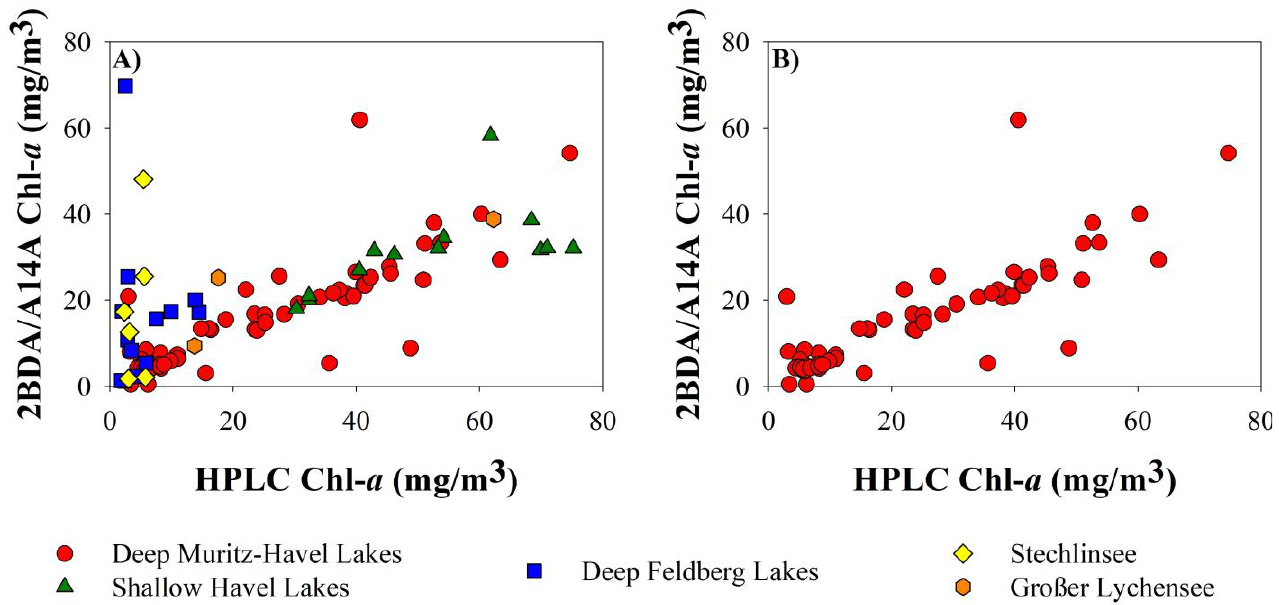
Figure 7. Measured HPLC chl- a concentration and 2BDA/A14A estimated chl- a concentration for: ( A ) the entire data set; ( B ) the Deep Müritz-Havel Lakes data set